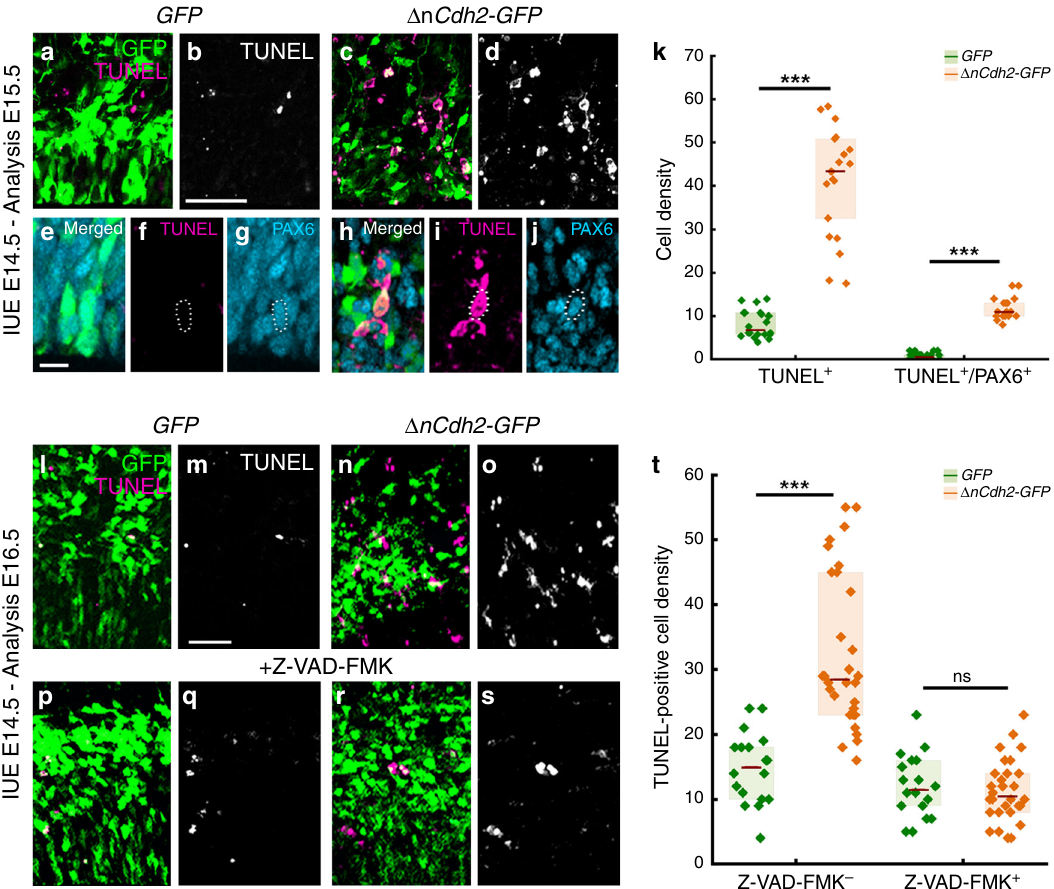
Fig. 2 Adherens junction disruption induces apoptosis in the prenatal neocortex. a – d Confocal images demonstrate that Δ nCdh2-GFP - ( c , d ) triggers increased cell death compared to control GFP -electroporation ( a , b ). e – g GFP-electroporated PAX6-expressing cells occasionally show TUNEL-labeling under control conditions. h – j Increased TUNEL-labeling density is observed in Δ nCdh2 -electroporated samples. Scattered line encircles a still morphologically intact Δ nCdh2 -electroporated, TUNEL-positive cell that has retained PAX6-immunostaining. k Density of TUNEL-positive and TUNEL/ PAX6 double-positive cells after electroporation at E15.5 (both cases: two-sided Mann-Whitney U test, P < 0.0001; n = 22 samples from n = 3 animals per GFP electroporation, n = 21 samples from n = 3 animals per Δ nCdh2-GFP electroporation). l – o Two days after the elimination of adherens junctions show elevated cell death in the electroporated area ( n , o ). p – s The pan-caspase inhibitor Z-VAD-FMK prevents cell death induced by Δ nCdh2-GFP- electroporation. t Density of TUNEL-positive dead cells in the electroporated area (Kruskal – Wallis test with post hoc Dunn ’ s Test; ***P < 0.0001; ns = not signi fi cant, P ≈ 1; n = 18 – 18 sections from n = 3 – 3 animals per GFP and GFP + Z-VAD-FMK treatment; n = 30 – 30 sections from n = 4 – 4 animals per Δ nCdh2-GFP and Δ nCdh2-GFP + Z-VAD-FMK treatment). Graphs show box-and-whisker plots (including minima, maxima, and median values, lower and upper quartiles) with single values. Scale bars: a – d , l – s : 50 μ m, e – j : 10 μ m. Source data are provided as a Source Data fi